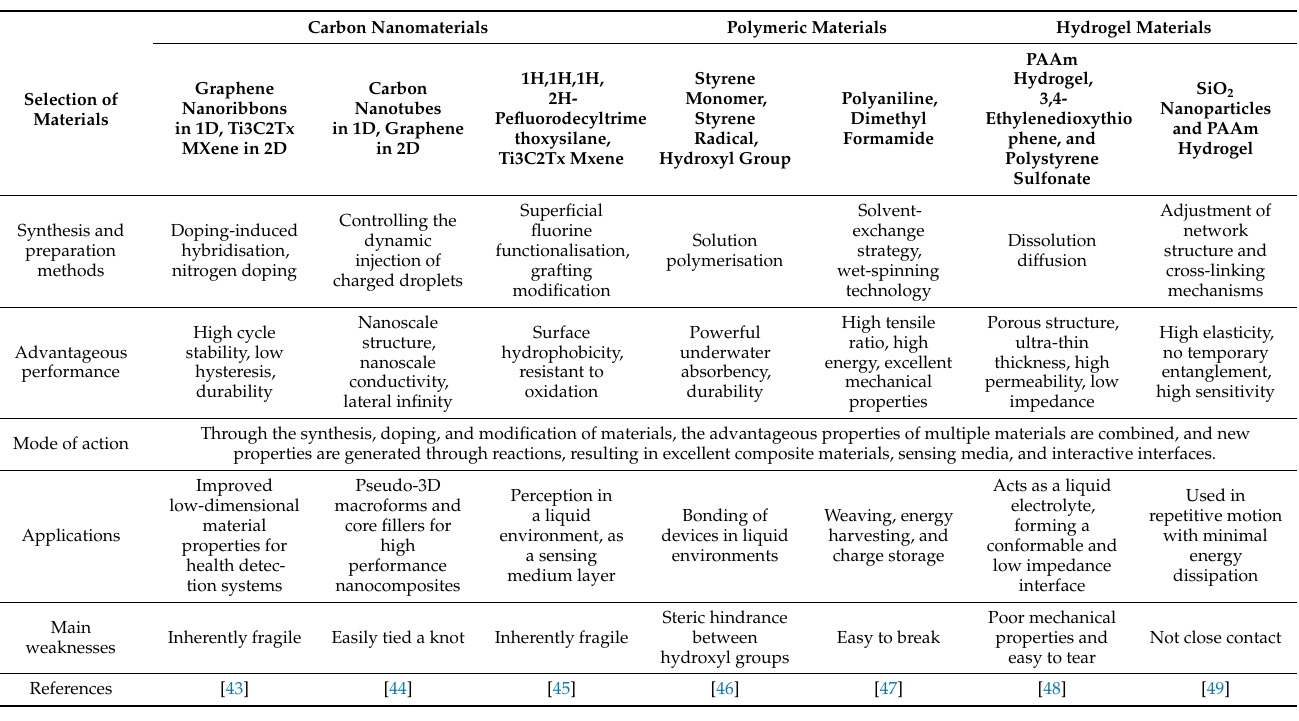
Table 1. Preparation methods, advantageous properties, modes of action, and some unique applica- tions of synthetic